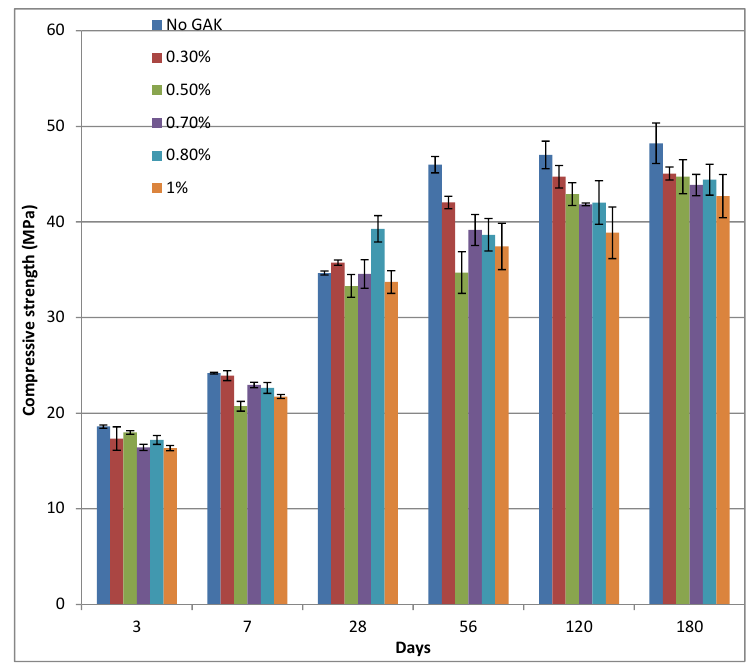
Figure 7. Compressive strength of concrete with different dosages of GAK and different w/b